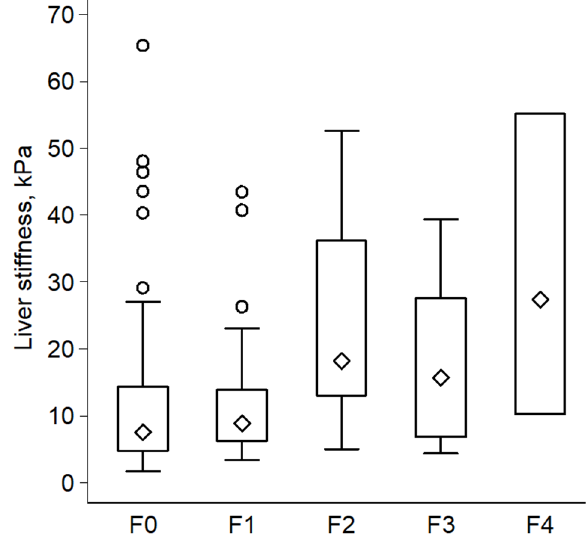
Figure 2. Boxplot illustrates distribution of liver-stiffness measurements over histological stages of fibrosis ( n = 167).